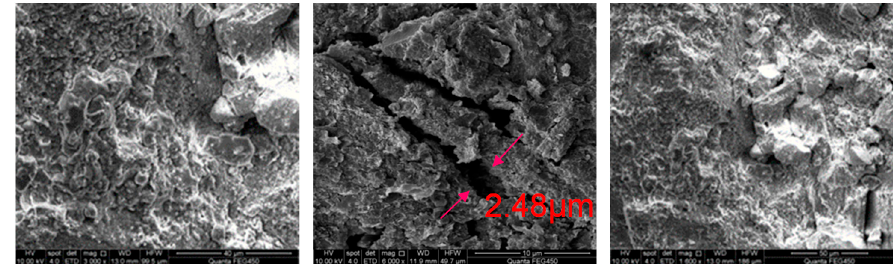
Figure 2. SEM image of deep shale in Nanpu block.